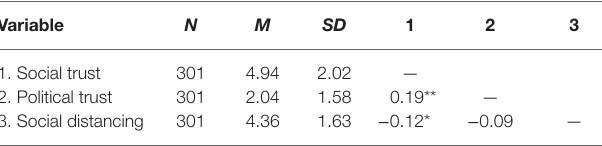
TABLE 1 | Descriptive statistics and correlations for social trust, political trust, and social distancing in Study 1. Variable